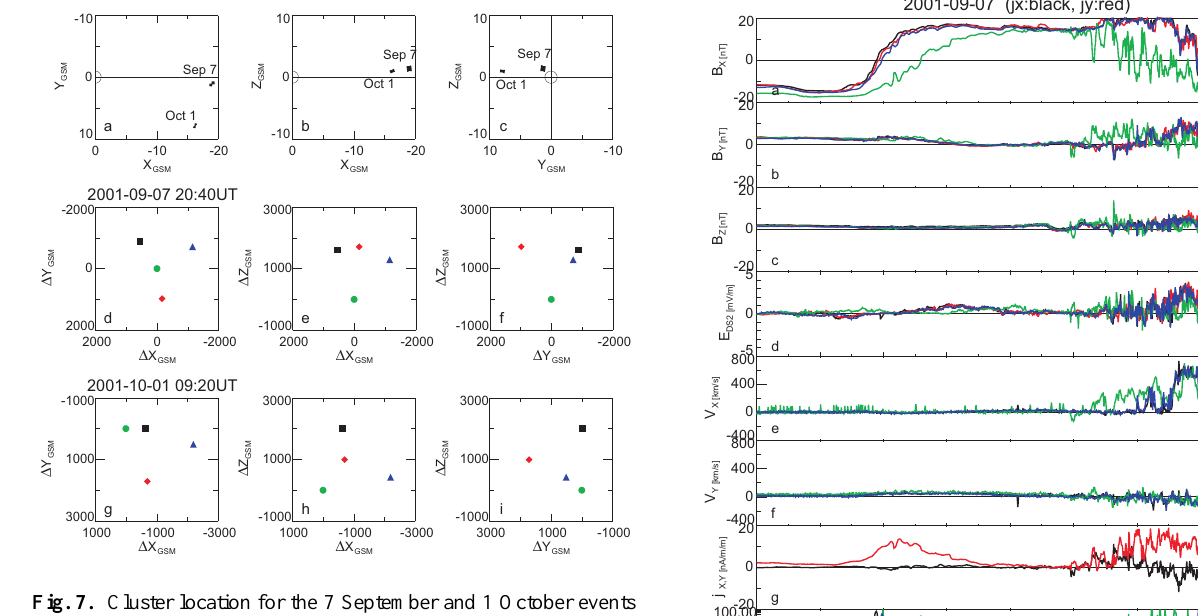
happened at the end of the selected time interval, around 22:00 UT. The Image and Polar spacecraft (data not shown) give evidence for an auroral bulge developing near the Clus- ter footprint, at about 21:29 UT. This bulge has a small ex- tension in latitude, around 70 ◦ MLat. Hence Event 1 is not a fully developed substorm; it corresponds to a localized (in latitude) perturbation propagating eastward at ∼ 50 km/s in the ionosphere, presumably a pseudo-breakup.